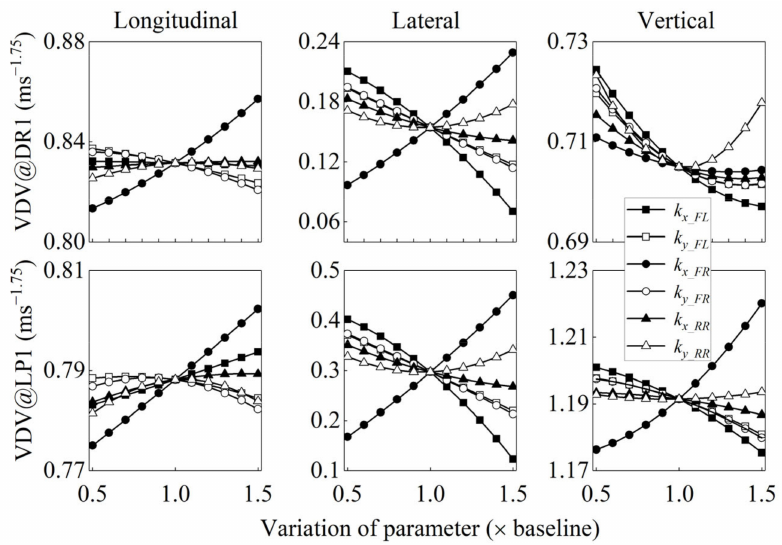
Figure 7. Main effects of significant parameters on the VDV at seat